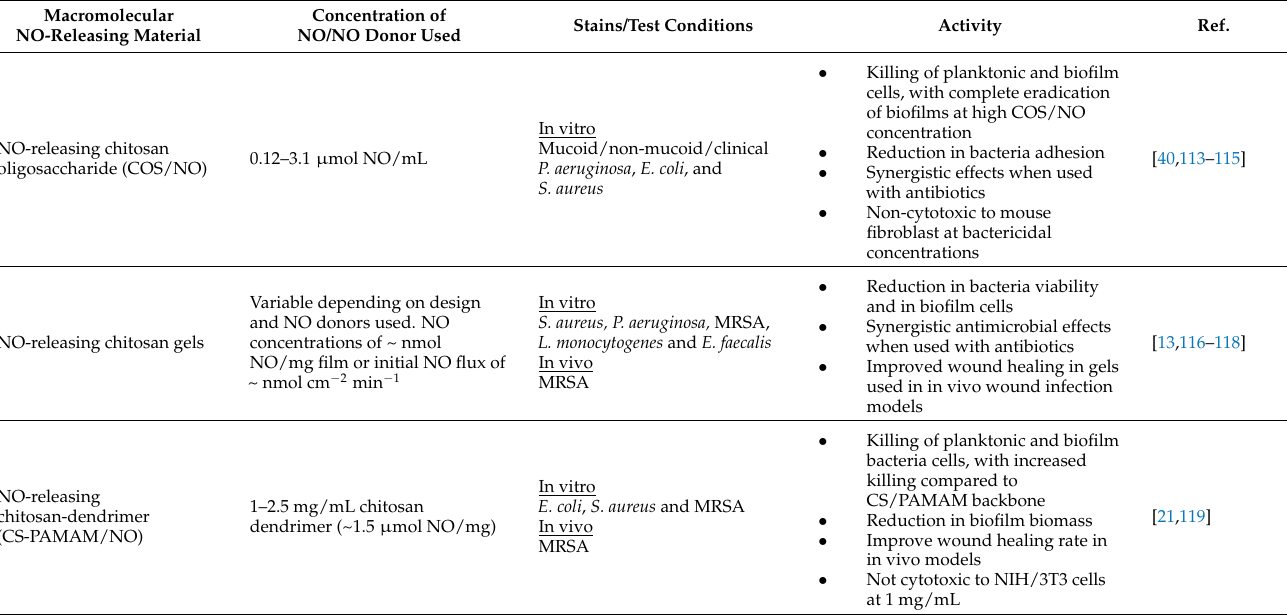
Table 3. Activity of various NO-releasing polymeric materials on planktonic and biofilm